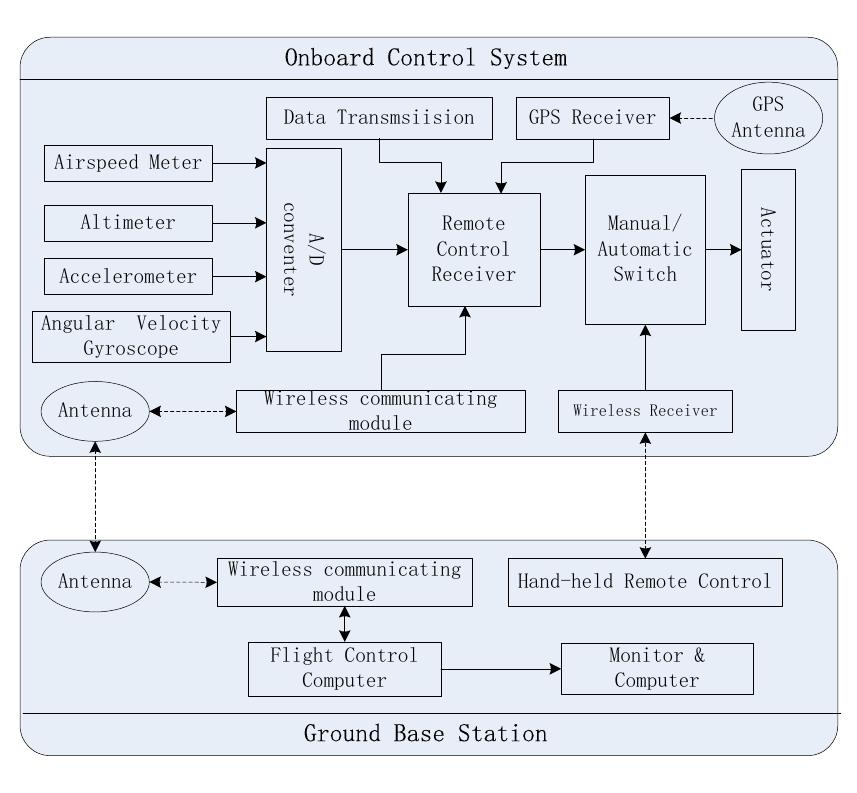
Figure 3. Onboard control and navigation